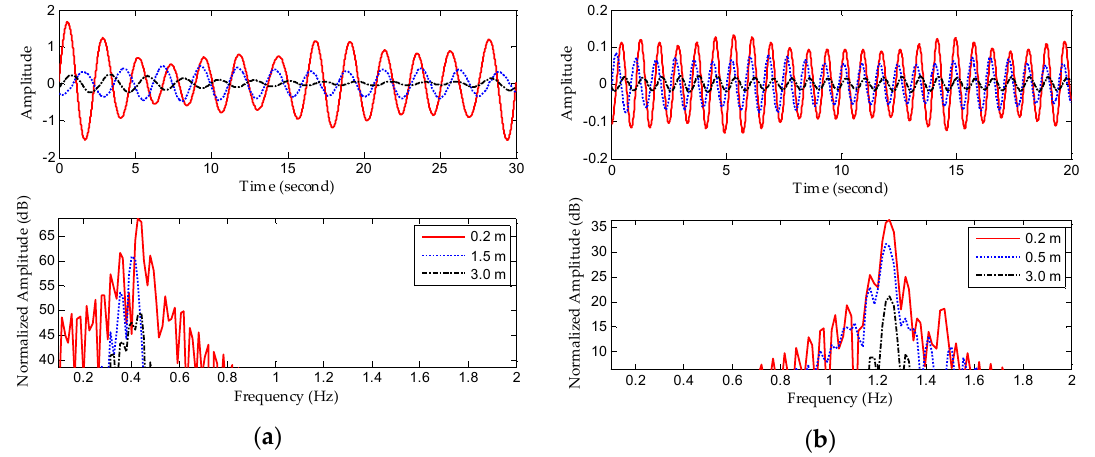
Figure 15. Detection results with different subjects at different distances. ( a ) Extracted respiration signals and frequency spectra; ( b ) extracted heartbeat signals and frequency spectra.